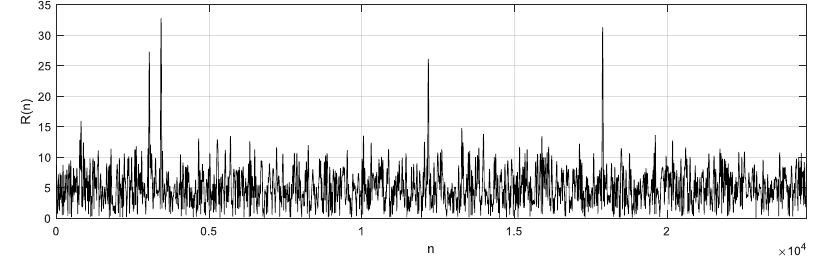
Figure 10. Four di ff erent preamble correlations. Figure 10. Four different preamble correlations.